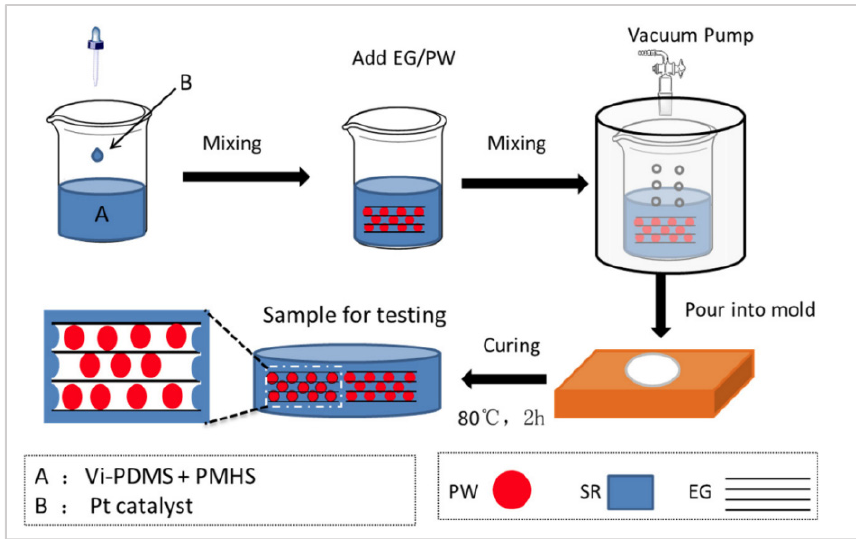
Figure 4. The preparation process of expanded graphite (EG)/paraffin wax